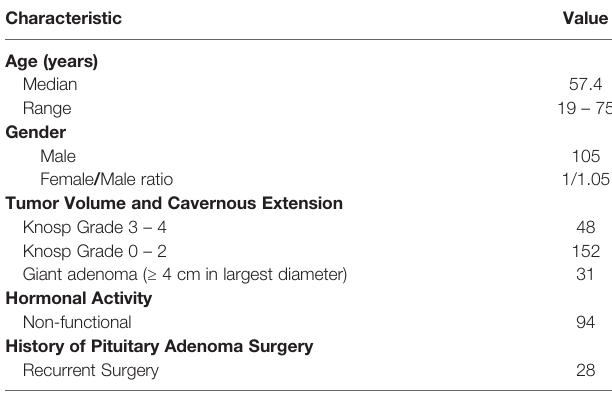
TABLE 1 | Demographic and tumor characteristics of 200 patients underwent endoscopic endonasal resection of pituitary adenoma with intraoperative magnetic resonance